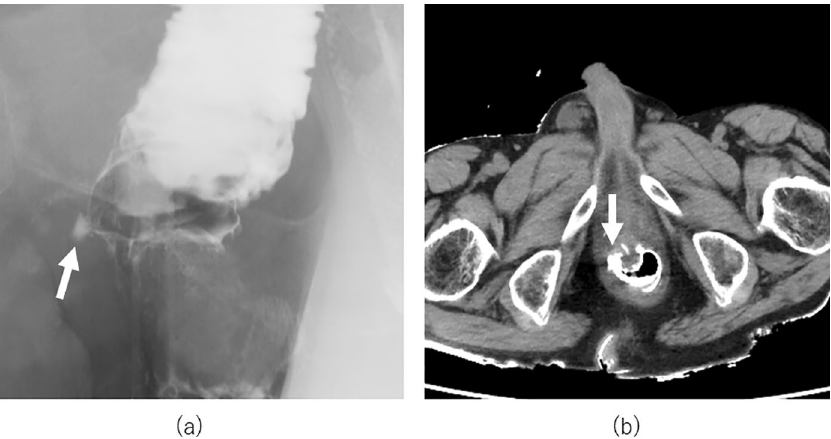
Figure 2. Contrast enema examination and computed tomography. A case of suspected anastomotic leakage is demonstrated. ( a ) The contrast medium flowed out of the intestinal tract. ( b ) The dehiscence of the anastomosis is difficult to identify on computed